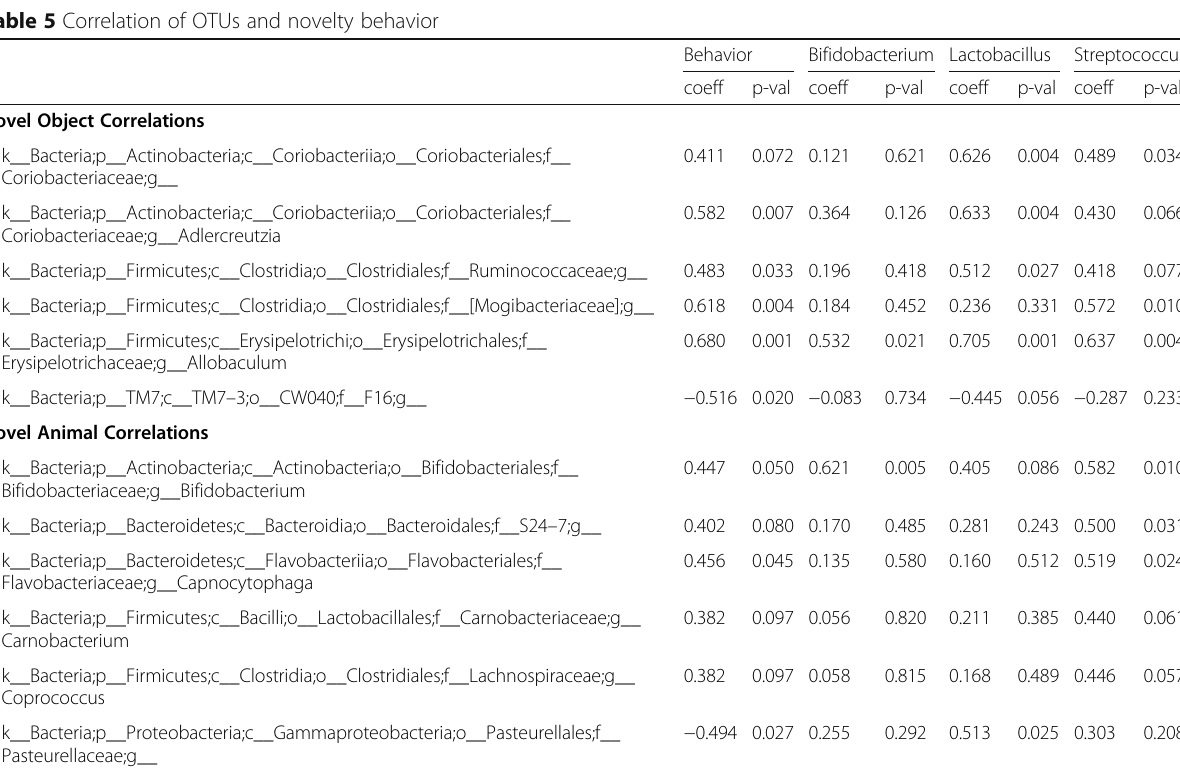
Behavior Bifidobacterium Lactobacillus Streptococcus coeff p-val coeff p-val coeff p-val coeff p-val